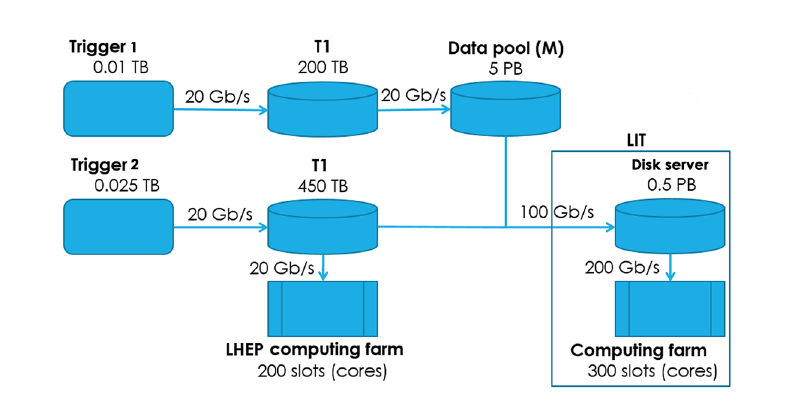
Figure 1. Schematic architecture of the distributed computing structure with specified hardware parameters